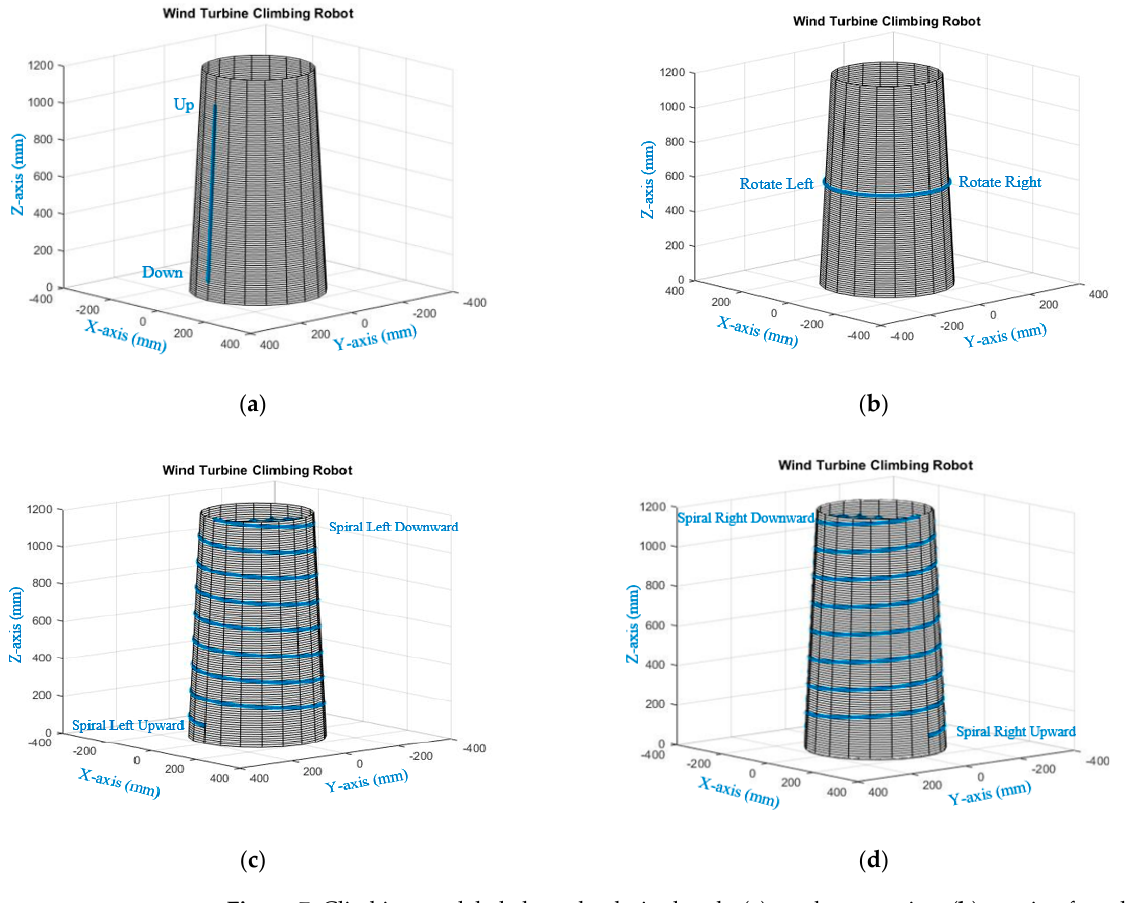
Figure 7. Climbing modeled along the desired path: ( a ) up-down motion; ( b ) rotation from left-right; ( c ) spiral left and upward-downward; ( d ) spiral right and upward-downward.